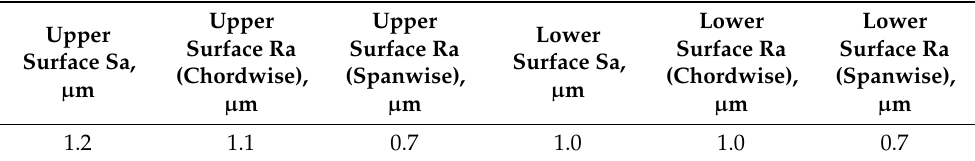
Table 5. Surface roughness of the flutter wing model at different locations.